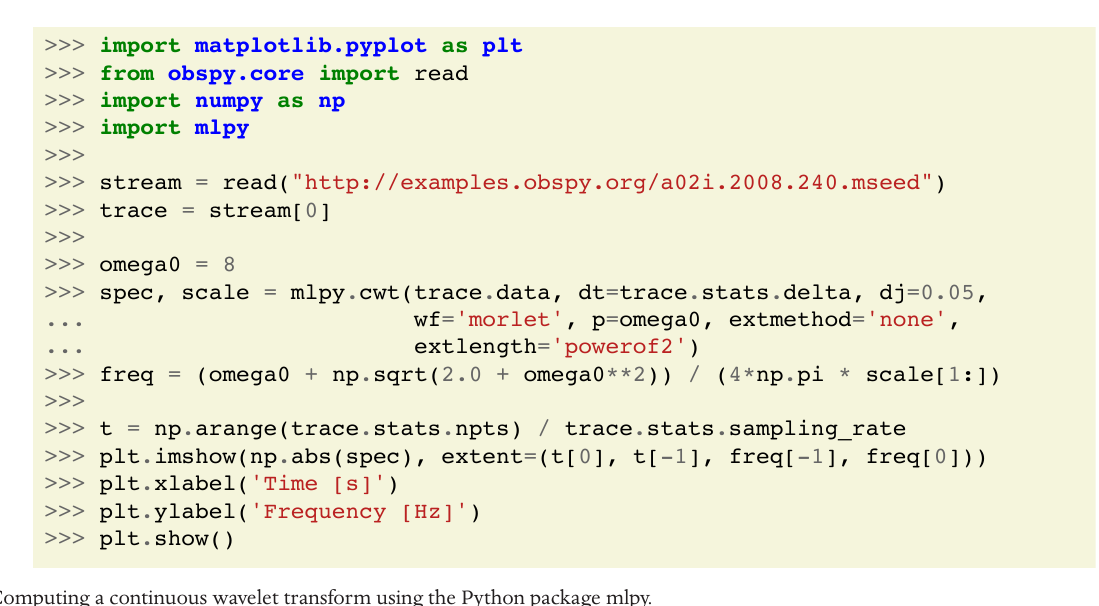
Figure 4. Computing a continuous wavelet transform using the Python package mlpy.